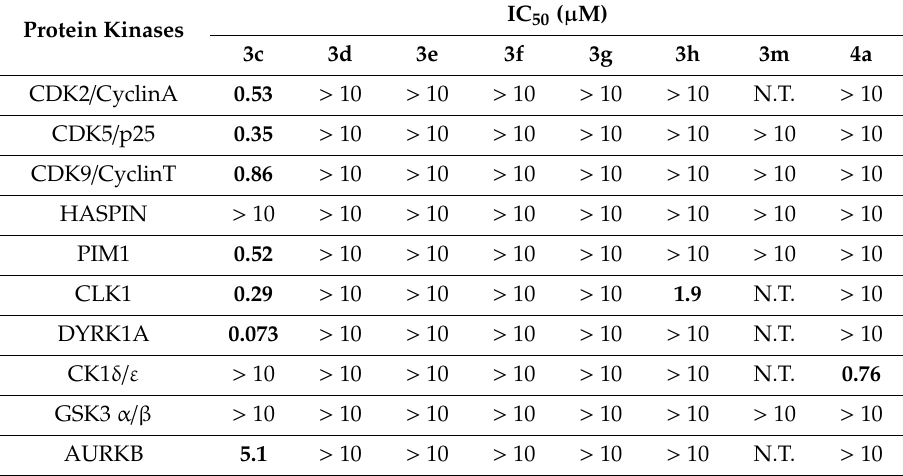
Table 3. Kinase inhibitory activity of arylsemicarbazone derivatives. Protein